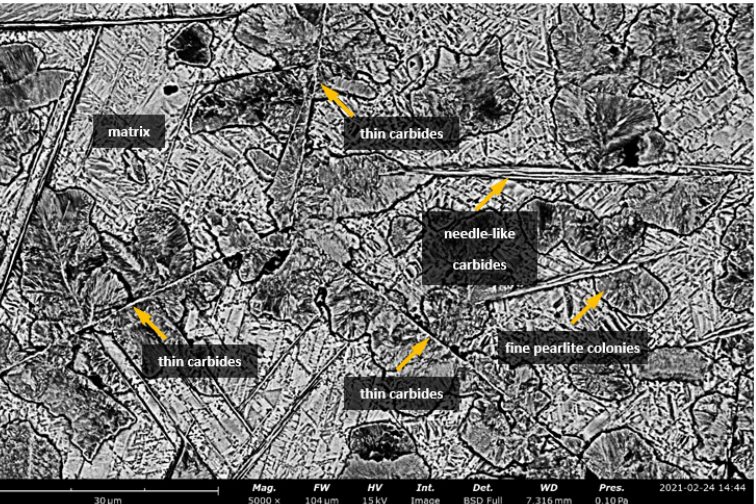
Figure 3. Microstructure of the X120Mn12 steel after isothermal annealing at 510 °C and cooling with the furnace. Visible heterogonous growth of new pearlite grains and needle-like precipitations at the grain boundaries of the former austenite, which are also the site of the nucleation of “thin” carbides. Etched state. SEM (BSE).